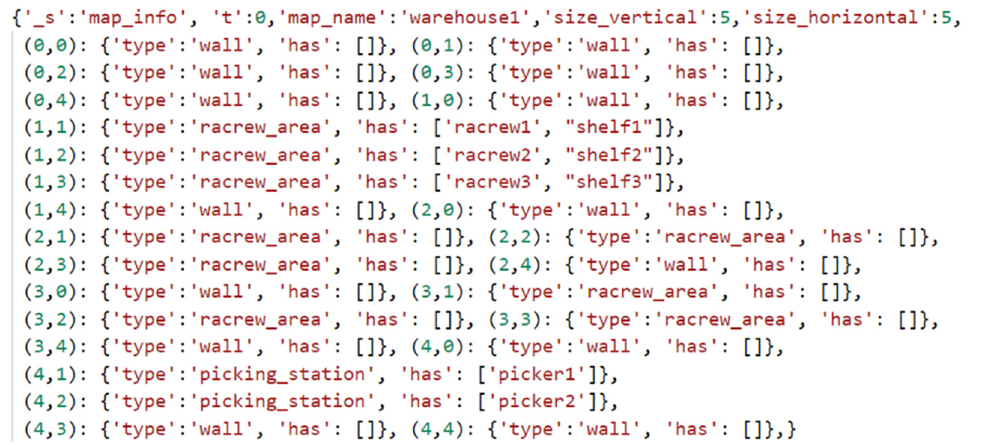
Figure 4. Fact architecture (example written in Python syntax).